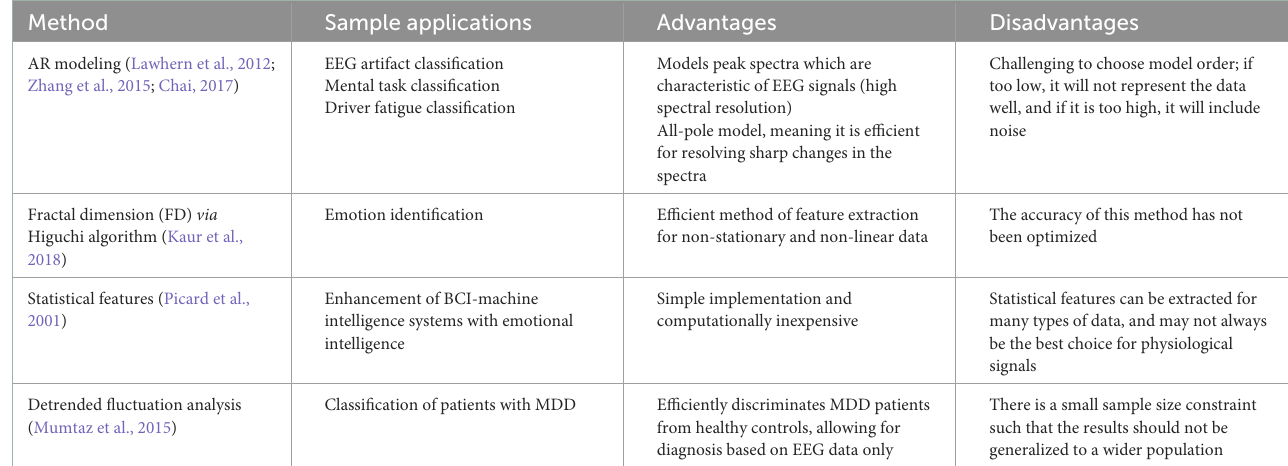
TABLE 1 Summary of time-domain feature extraction methods for EEG.